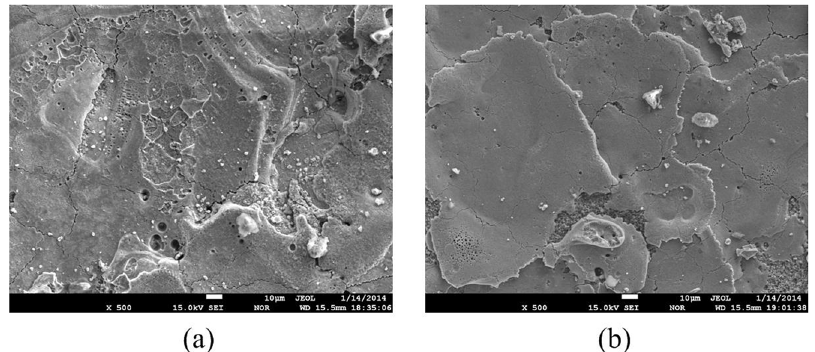
Figure 15. Micrographs of machined ZnO/Al 2 O 3 ceramic surfaces with different tool polarities: (a) tool(-); (b) tool( + ).